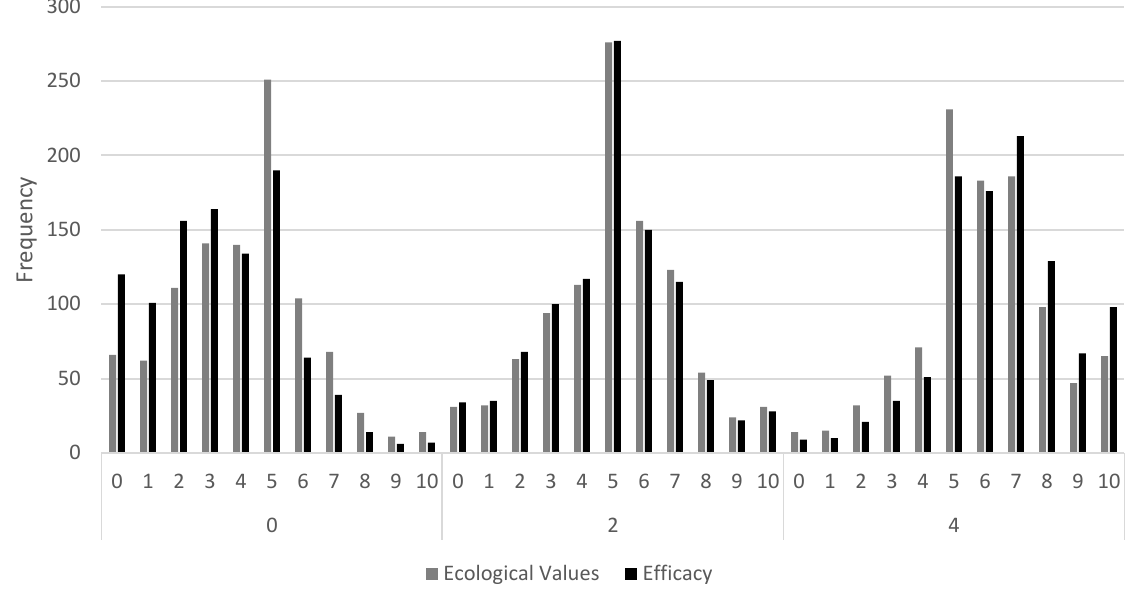
Figure 2. Simulated Influence of ecological values and efficacy on health risk perceptions in the community group.